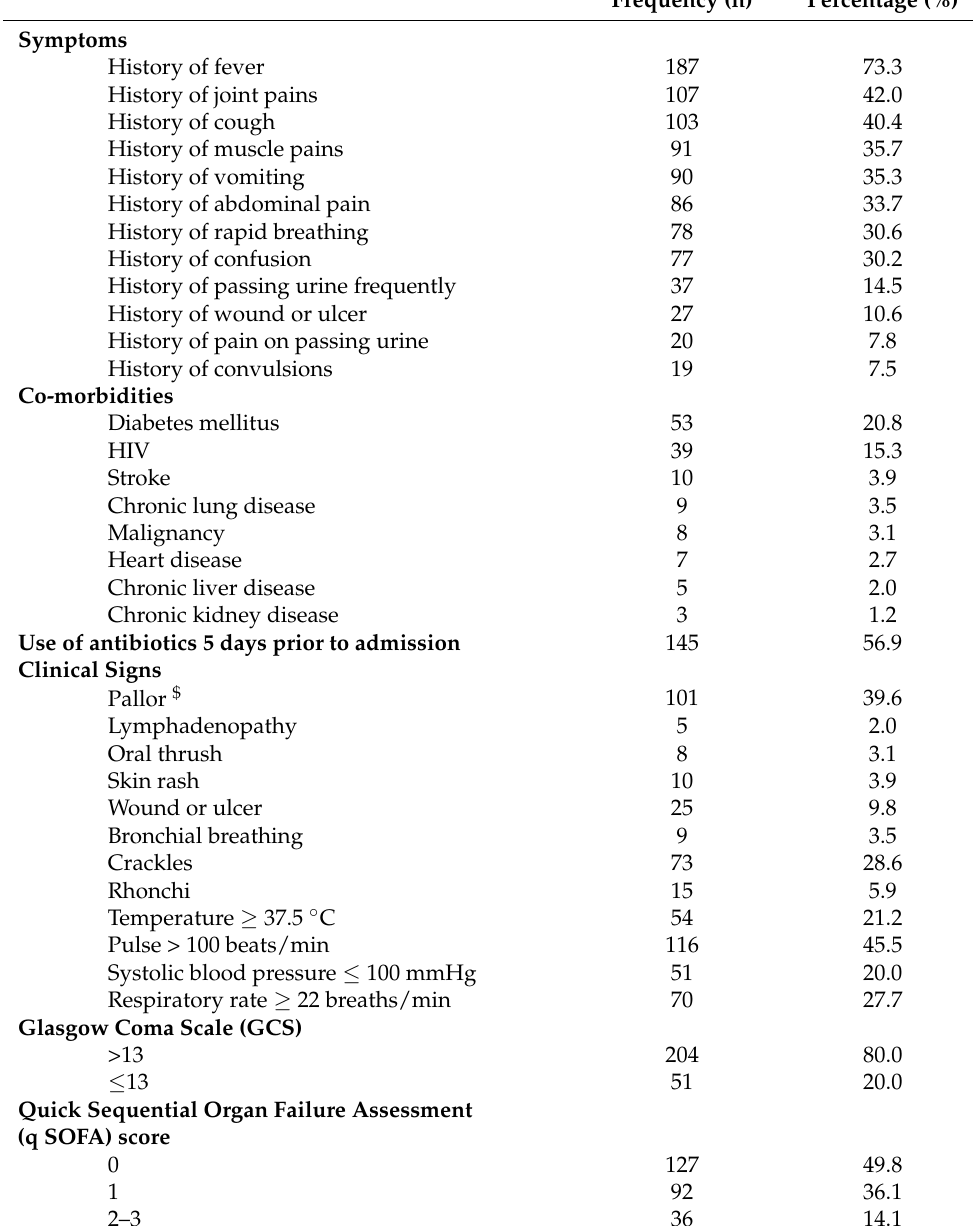
Table 1. Clinical characteristics of the study